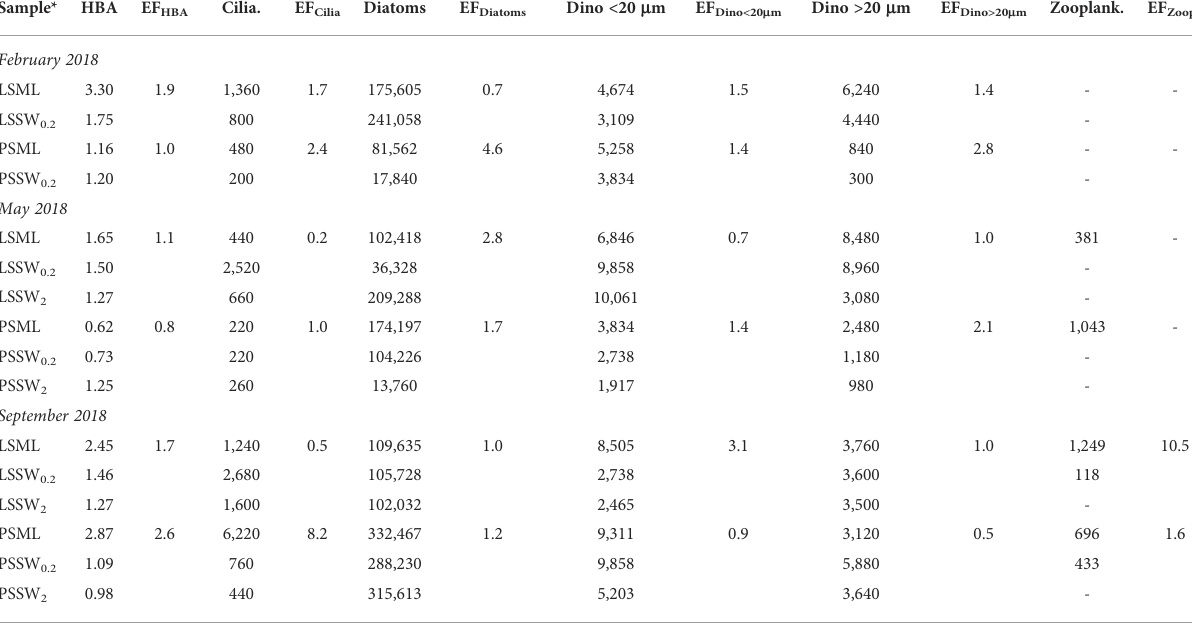
TABLE 3 Biological parameter abundance (cells L -1 , except for bacteria expressed as ×10 6 HBA mL -1 and zooplankton expressed as ind. m -3 ) and their enrichment factors (EFs) in the marine surface microlayer. Sample* HBA EF HBA